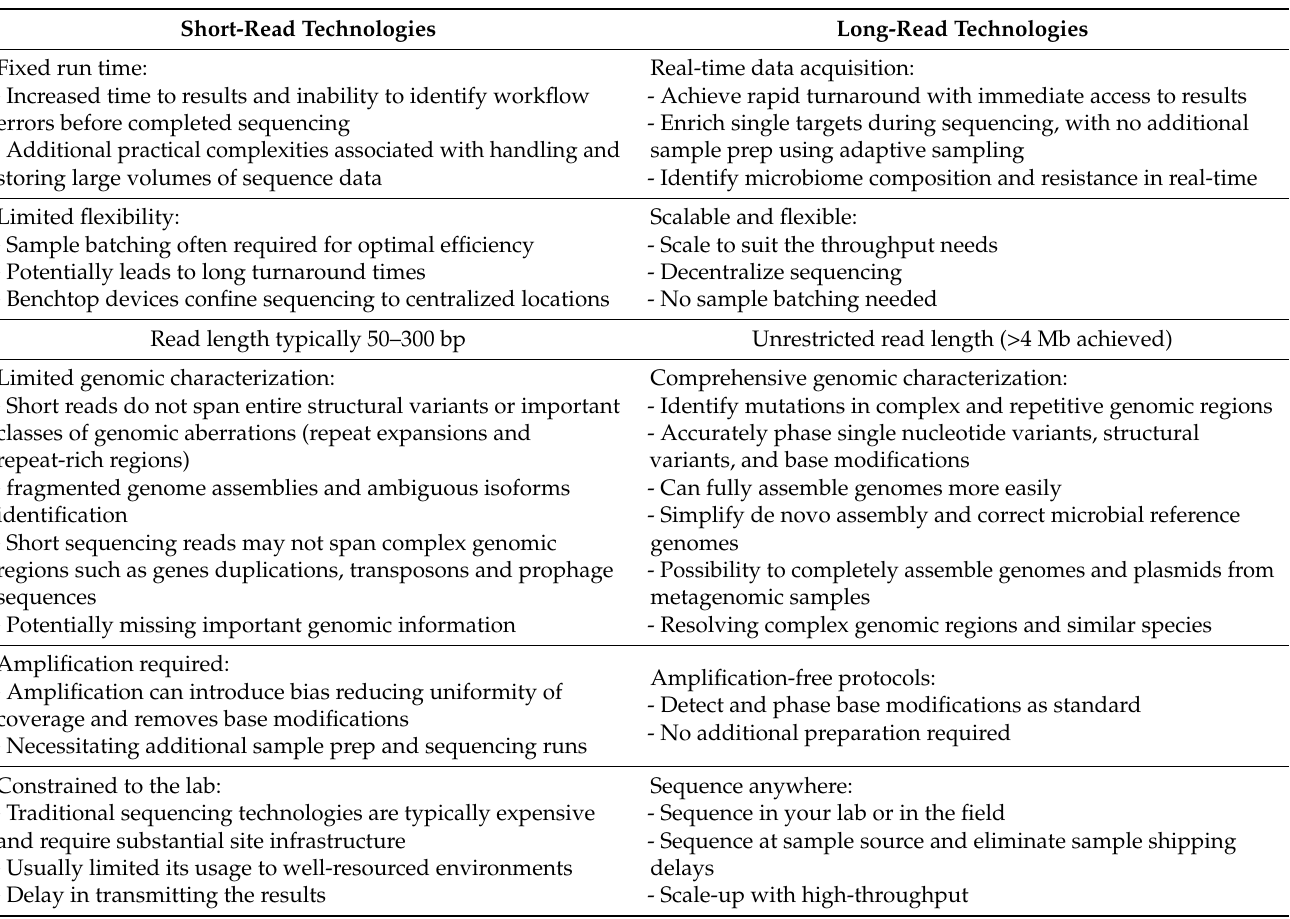
Table 1. Summary of the main advantages of long-reads sequencing over short-read